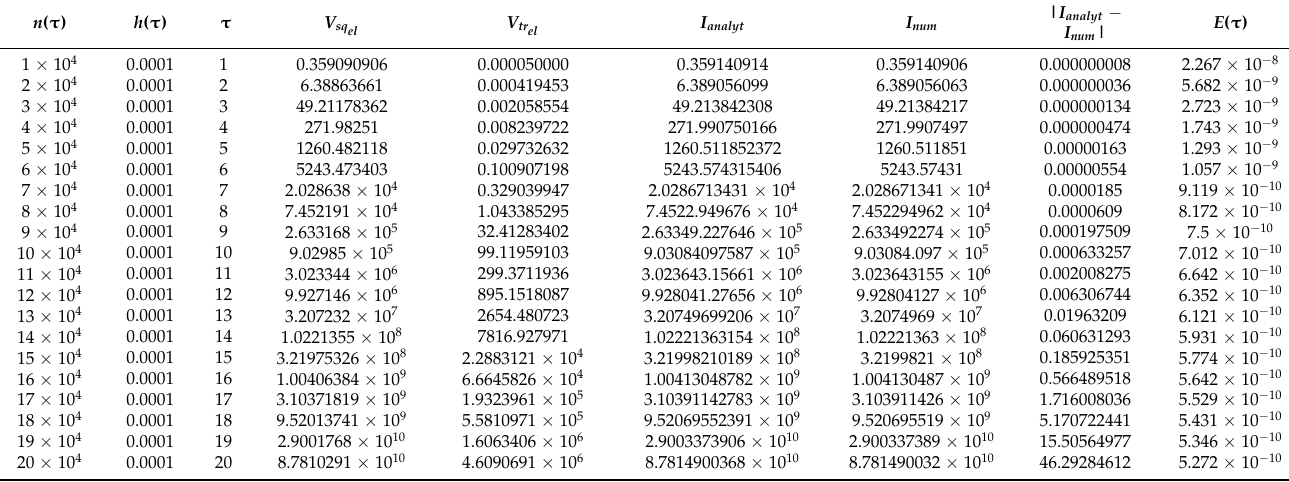
Table 6. Calculation of integral